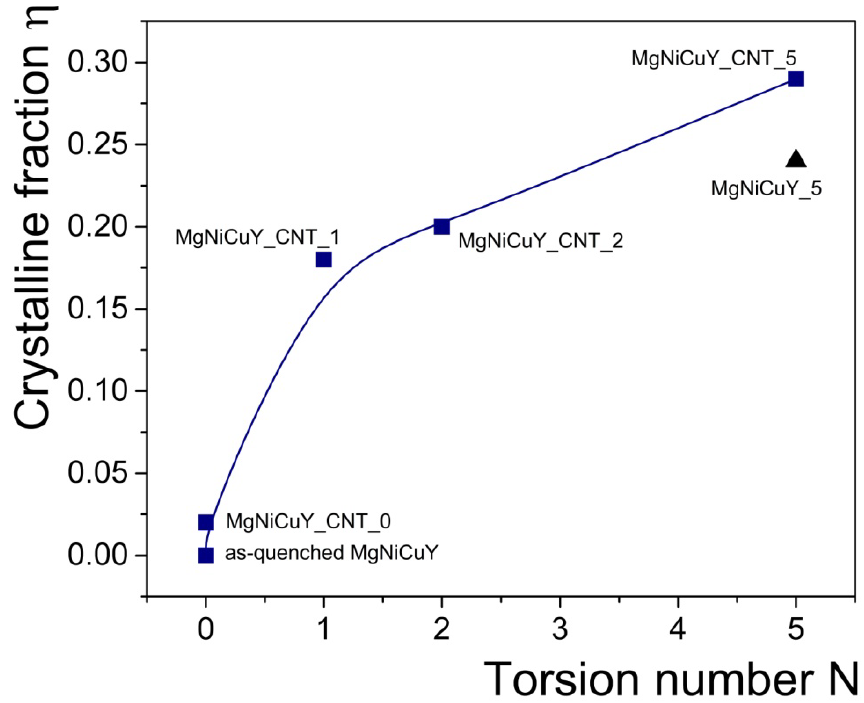
Figure 6. Crystalline fraction obtained for the different HPT disks as a function of the torsion number. The continuous line is a guideline for the eye.